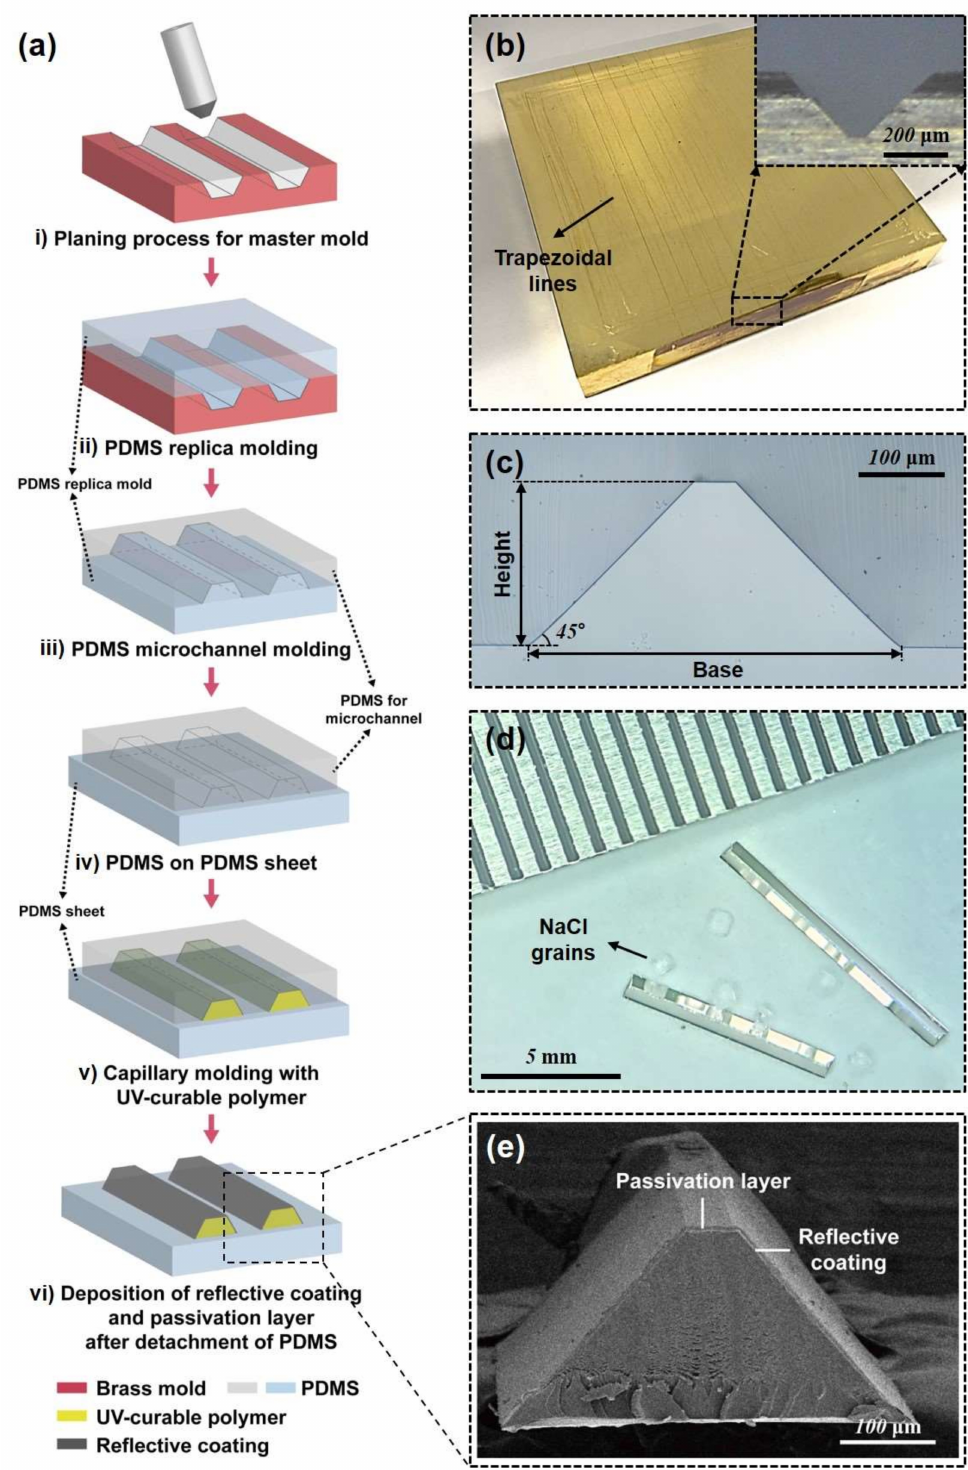
Figure 2. A fabrication process for a micromirror. ( a ) Fabrication steps for trapezoidal micromirror. ( b ) Brass mater mold with a trapezoidal cross-section. ( c ) Cross-section view of PDMS channel. ( d ) Optical microscopic image of micromirrors with grains of salt. ( e ) SEM images of a micromirror. A micromirror-embedded coverslip assembly consists of two coverslips with di ff erent sizes (22 mm × 22 mm and 24 mm × 50 mm, ~120–170 µ m thickness), where the trapezoidal micromirror is embedded on each coverslip (Figure 3). Two types of parallel column structures were designed